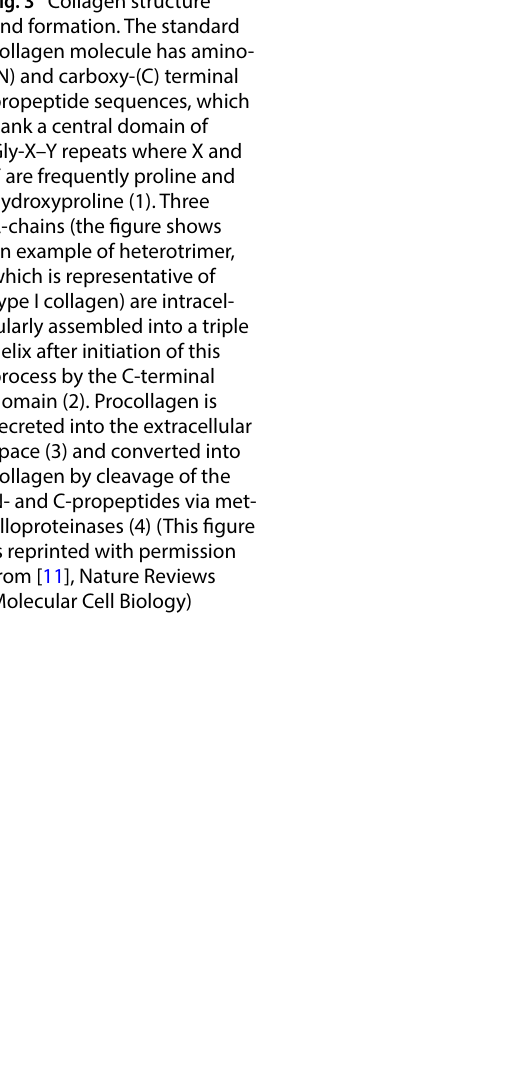
Fig. 3 Collagen structure and formation. The standard collagen molecule has amino- (N) and carboxy-(C) terminal propeptide sequences, which flank a central domain of Gly-X–Y repeats where X and Y are frequently proline and hydroxyproline (1). Three α-chains (the figure shows an example of heterotrimer, which is representative of type I collagen) are intracel- lularly assembled into a triple helix after initiation of this process by the C-terminal domain (2). Procollagen is secreted into the extracellular space (3) and converted into collagen by cleavage of the N- and C-propeptides via met- alloproteinases (4) (This figure is reprinted with permission from [11], Nature